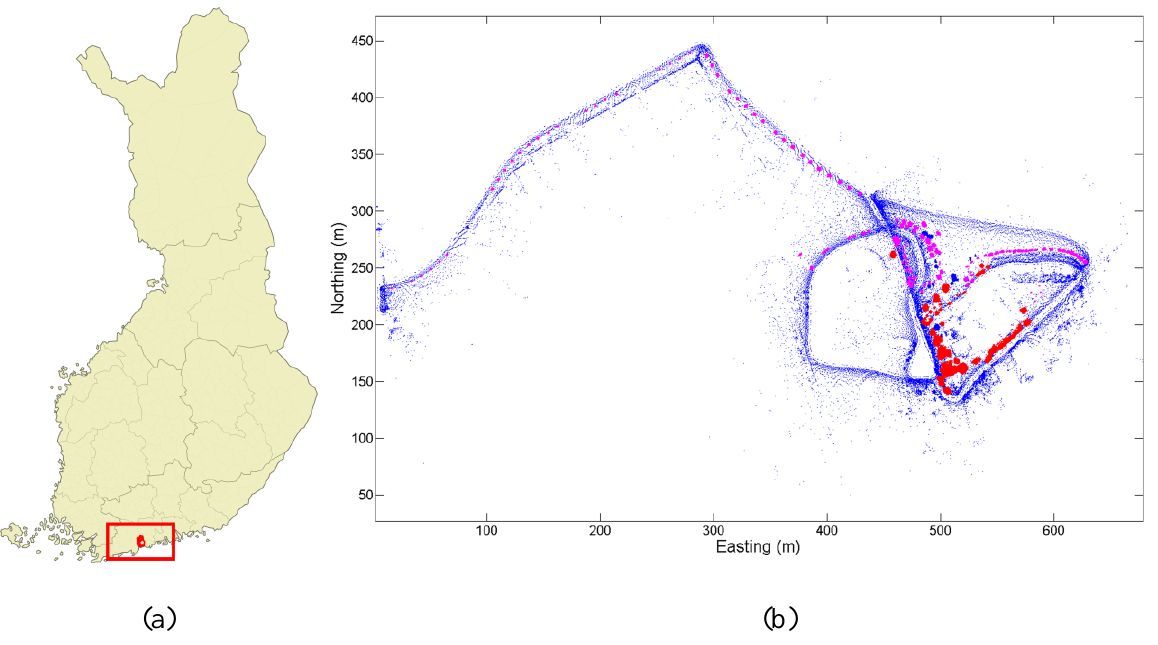
Figure 3. The Vanttila test area location is shown on a map of Finland ( a ) and an overview is presented of the test area ( b ). The overview image is drawn with the measured point cloud. The red and magenta objects are the determined trees used in classifications. Magenta objects have been included both in tree species classification and in coniferous-deciduous tree separation while red objects are only used in coniferous-deciduous tree separation. Blue areas represent the rest of the data (the map of Finland was retrieved from Wikipedia, created by user